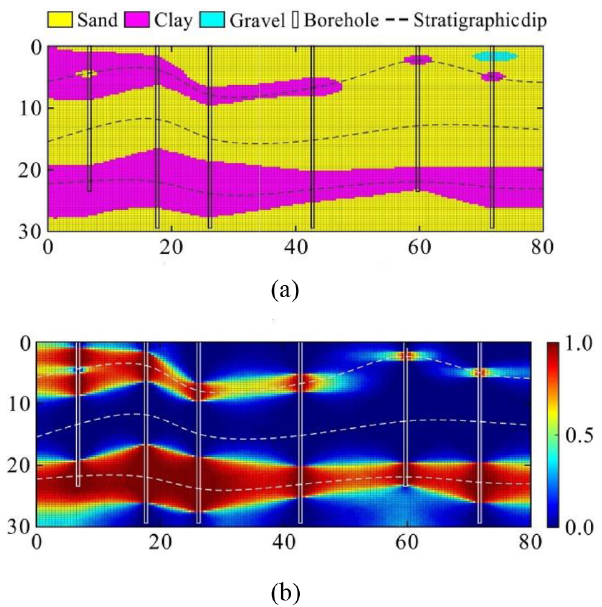
Figure 3. Zhao et al. (2021) findings shown in their Fig. 9. (a) Most probable stratigraphic configuration. (b) Spatial distribution of the probability of the existence of clay. Reprinted from Engineering Ge- ology, 238, Zhao et al. (2021), Probabilistic characterisation of sub- surface stratigraphic configuration with modified random field ap- proach, p. 106138, © 2021, with permission from the COPYRIGHT OWNER: Elsevier. Distances in